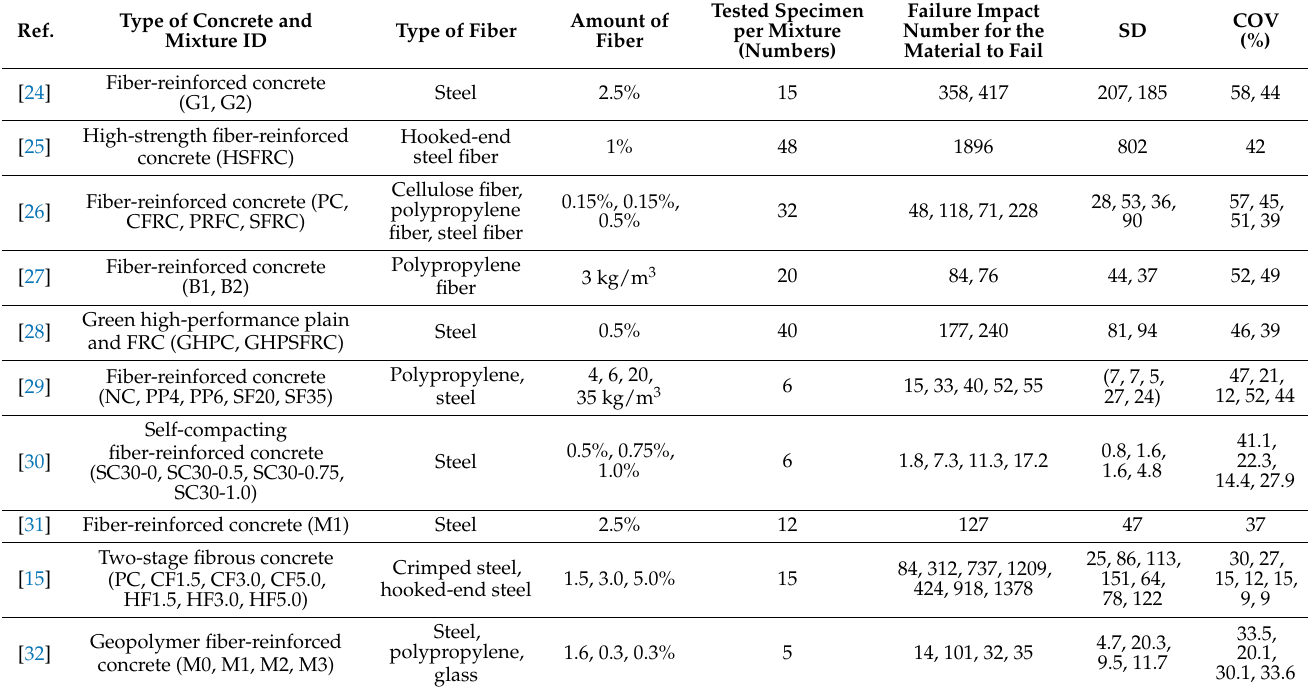
Table 1. A summary of the ACI falling mass impact